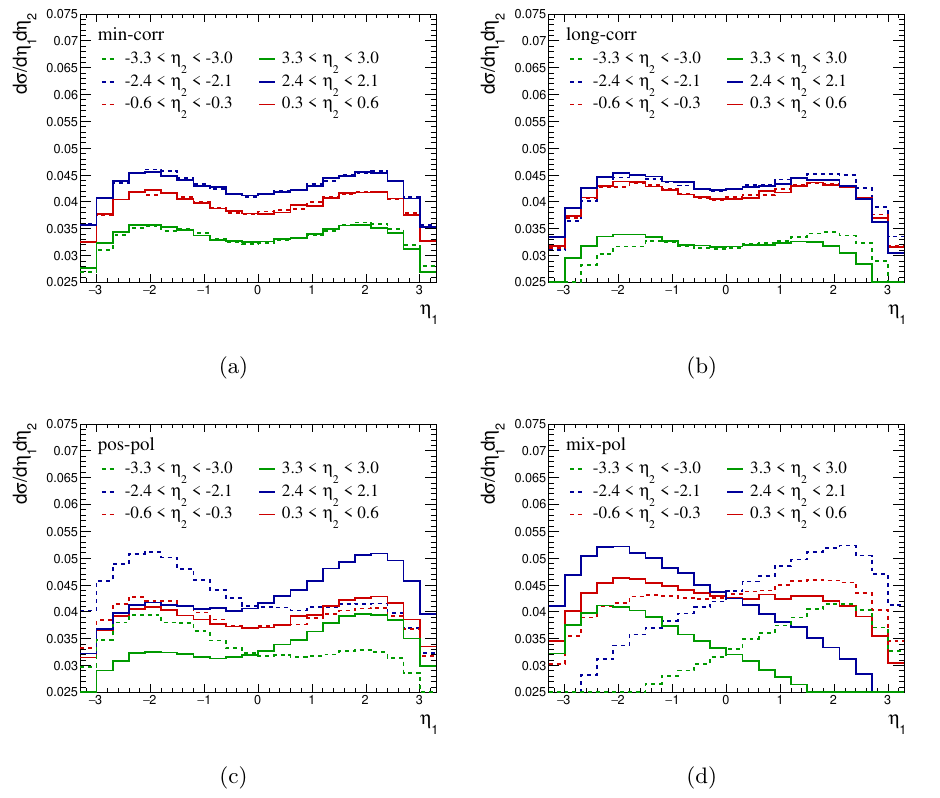
Figure 4 . Double-di(cid:11)erential distribution for rapidity of the two muons plotted for (cid:12)xed value of (cid:17) 2 . Di(cid:11)erent scenarios are plotted in separate panels as indicated in the